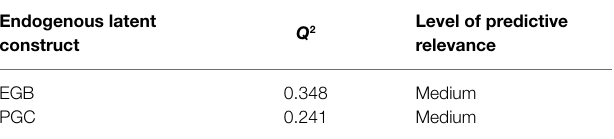
TABLE 11 | Predictive relevance ( Q 2 ).